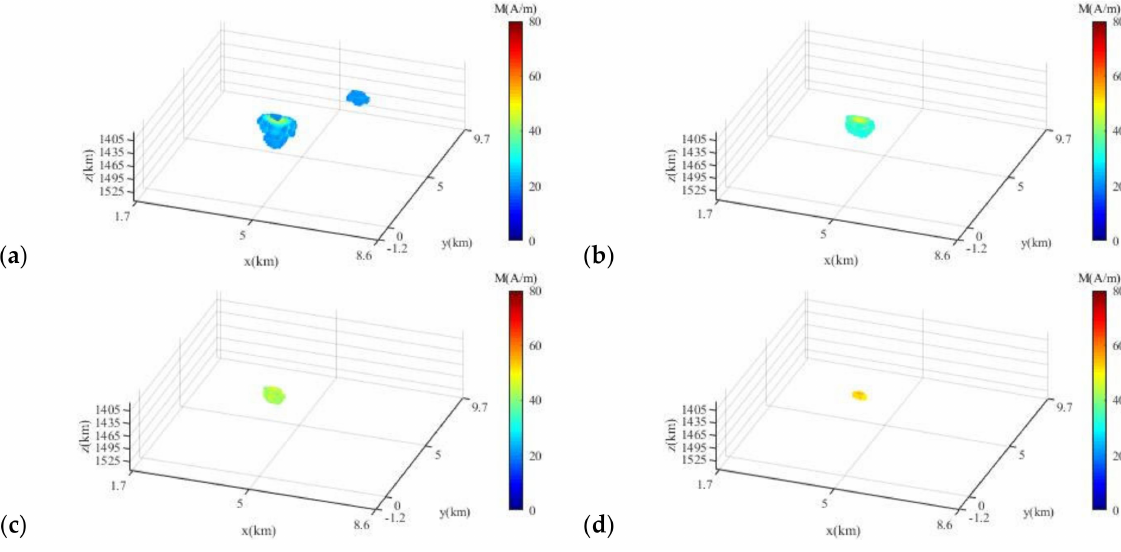
Figure 14. Inversion results of a magnetite-caused anomaly in Pandian Pluton subregion: ( a ) magnetization less than 20 A/m removed; ( b ) magnetization less than 30 A/m removed; ( c ) magnetization less than 40 A/m removed; ( d ) magnetization less than 50 A/m